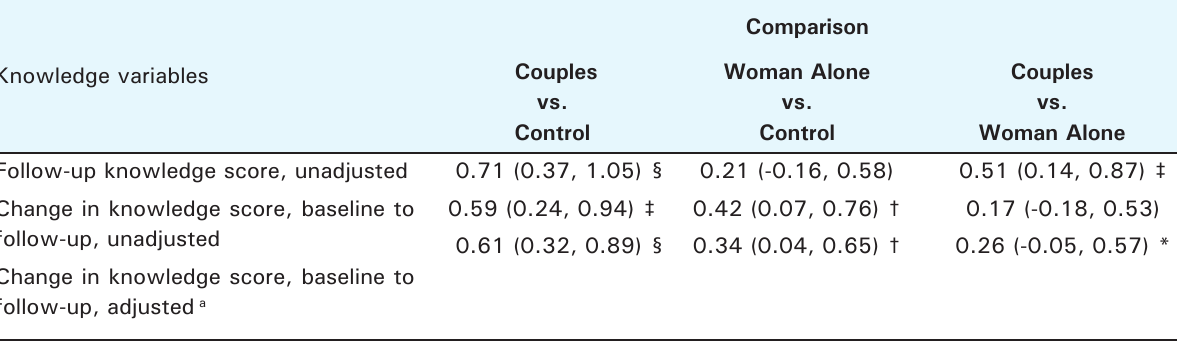
table 2. Unadjusted and adjusted coefficients and 95% confidence intervals from linear regression models of women’s knowledge scores (n=386).